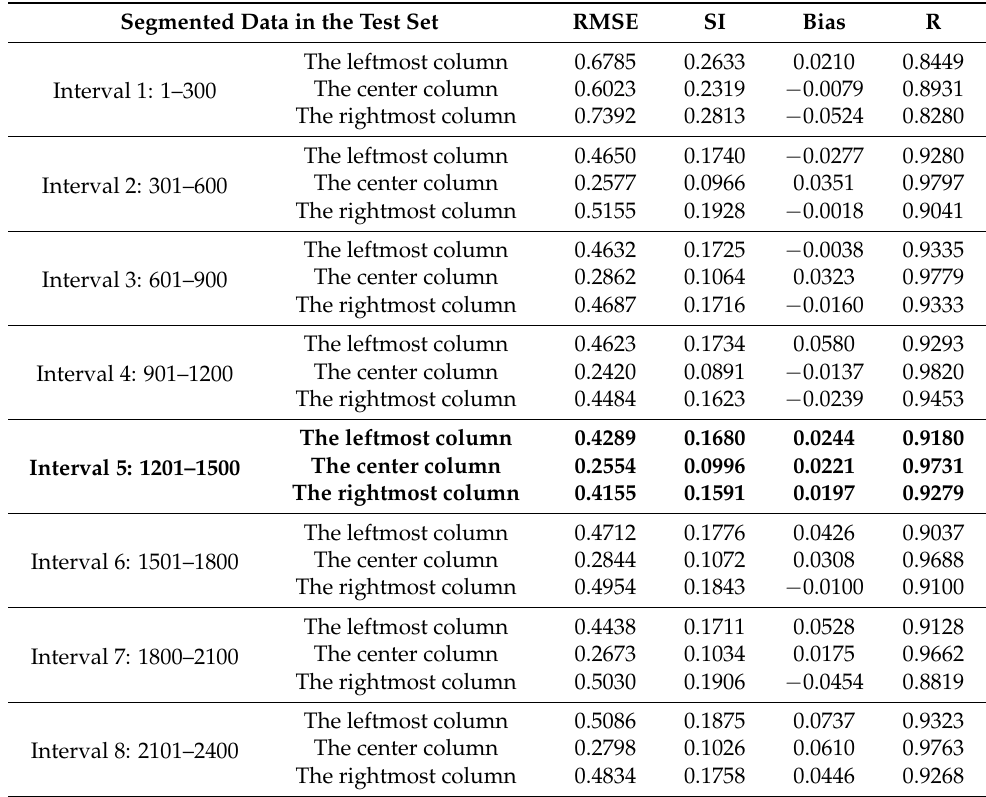
Table 2. The numerical results of the segmented data on the leftmost, center, and rightmost columns in Experiment 1. The Interval 5 (in bold) is selected to display the range and performance of the three columns of